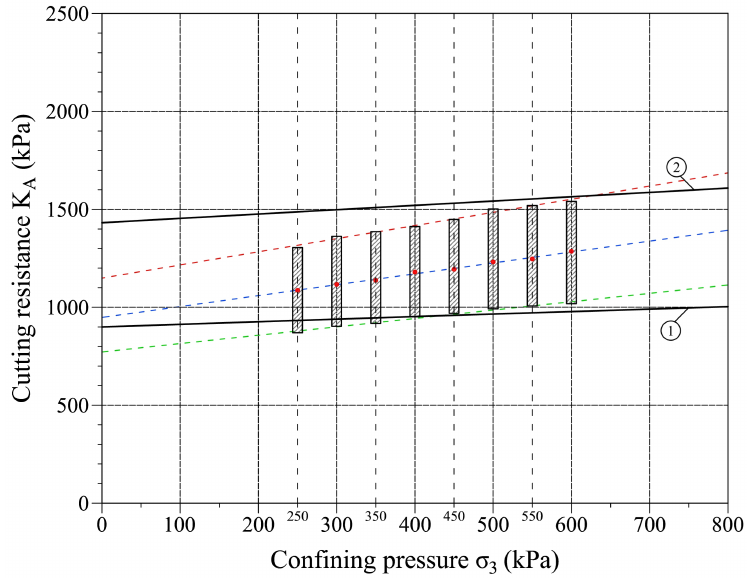
Figure 22. Comparison of the results of the modified wedge test and empirical cutting resistance values (1—lowest value of K A , 2—highest value of K A ).